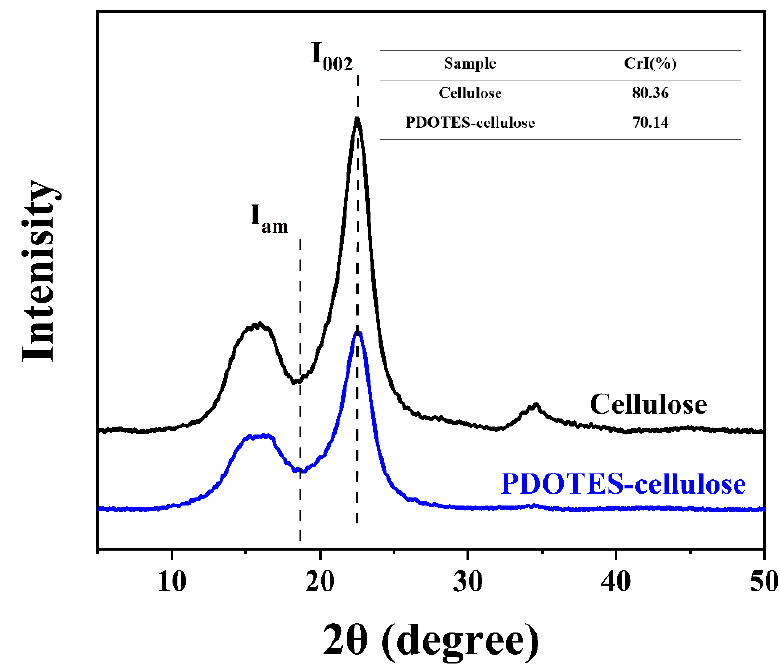
Figure 4. XRD spectrum of cellulose before and after modification.